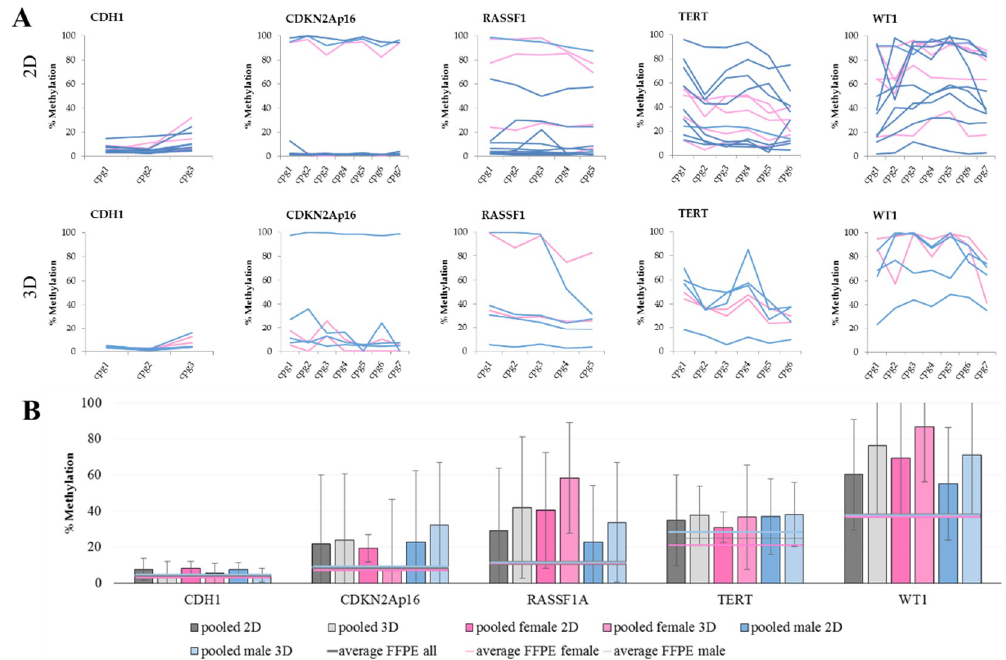
Figure 2. DNA methylation in cell lines. ( A ) The methylation levels over all analyzed CpG sites in 2D (top) and 3D (bottom) culture. Each line represents one female (pink) or male (blue) cell line. Within CGIs, the CpG sites show a fluctuation in methylation levels. This observation especially pertains to RASSF1A, TERT , and WT1 in both culture conditions, as well as for CDKN2Ap16 in 3D culture. ( B ) The average DNA methylation levels with standard deviation of grouped cell lines in the five marker genes analyzed in 2D and 3D cultures, shown as pooled values as well as pooled female and pooled male. Furthermore, average values of male, female, and all FFPE samples were added for reference.